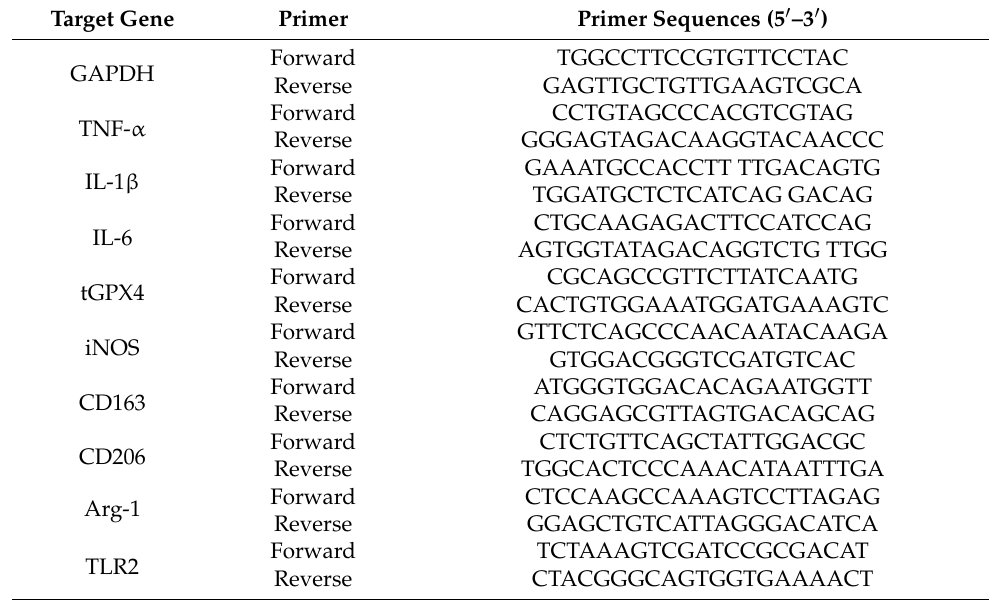
Table 1. Primer sequences of the target